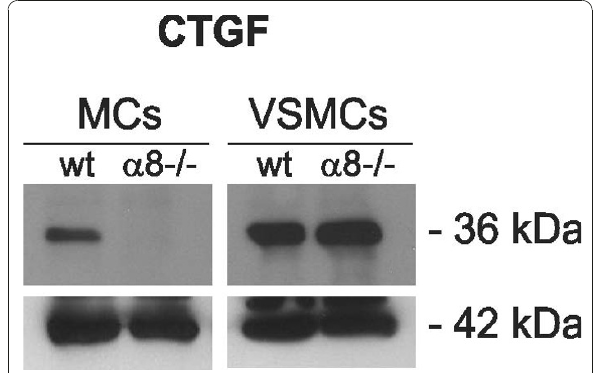
Figure 7 Connective tissue growth factor (CTGF; 36 kDa) protein expression in wild type (wt) and a 8 integrin-deficient ( a 8-/-) mesangial cells (MCs) and vascular smooth muscle cells (VSCMs) . Staining for b -actin was used as a loading control. Results are representative for 3 similar